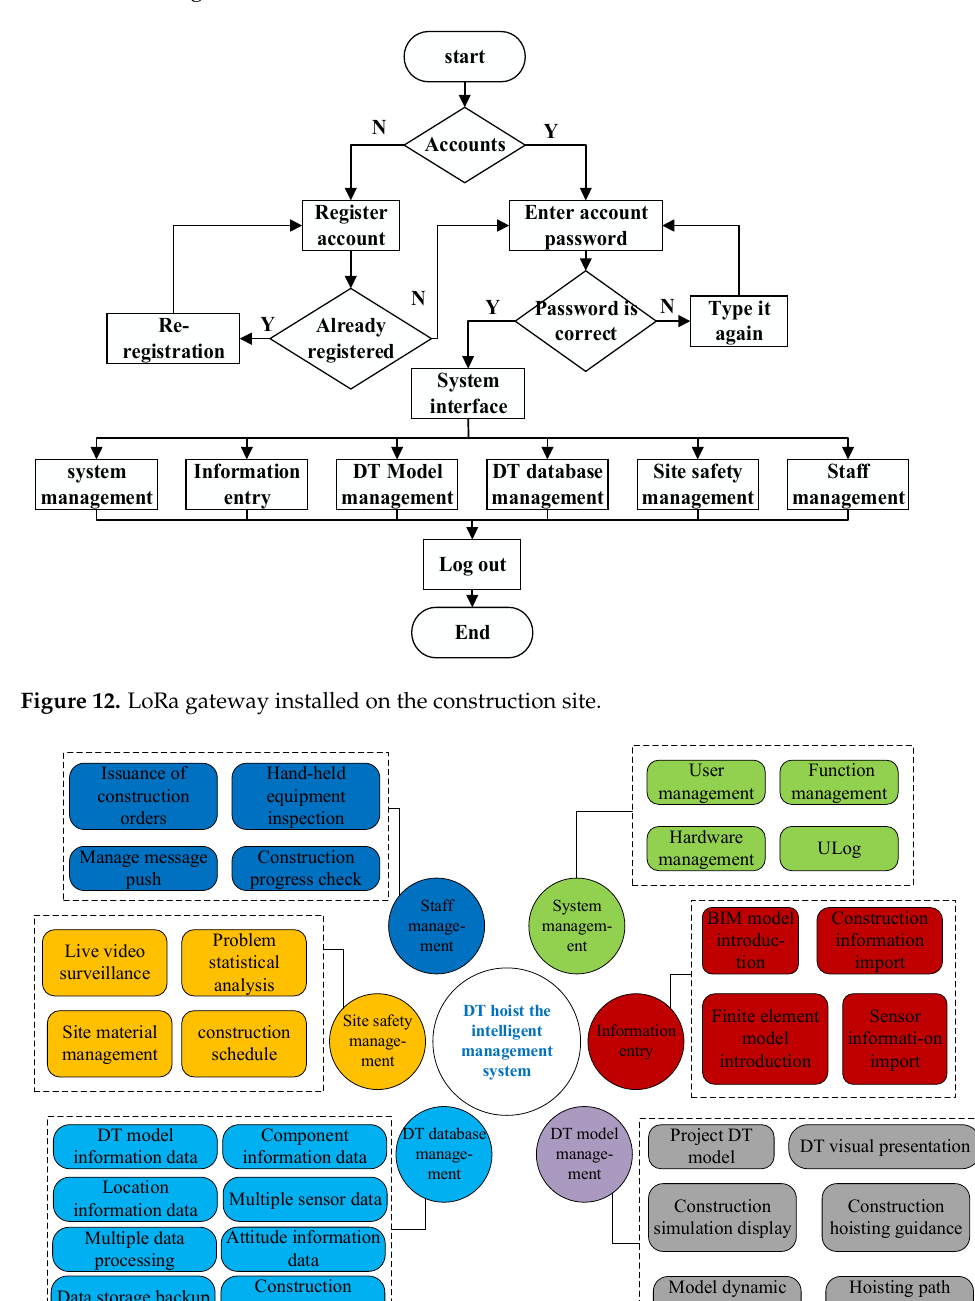
Figure 13. Analysis of system platform functional architecture.